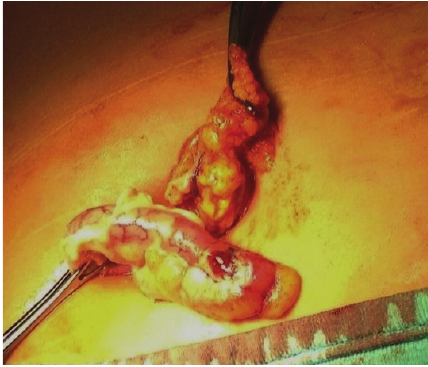
Figure 1: Gangrenous appendicitis exteriorized